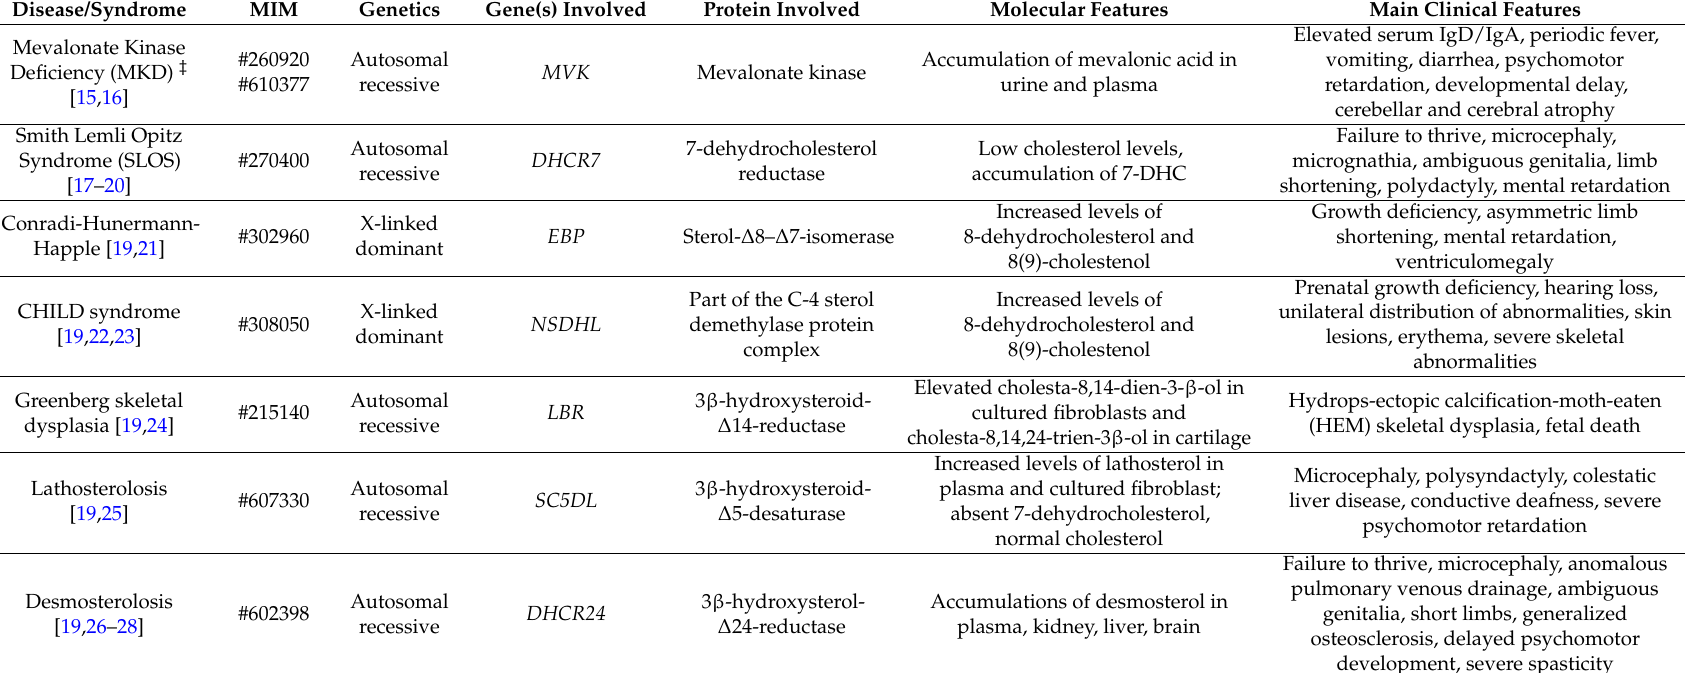
‡ Table 1. List of disorders triggered by alterations on cholesterol pathway. Mutations in the MVK gene cause MKD that range from Hyper-IgD syndrome to Mevalonic aciduria, depending on the type and severity of the